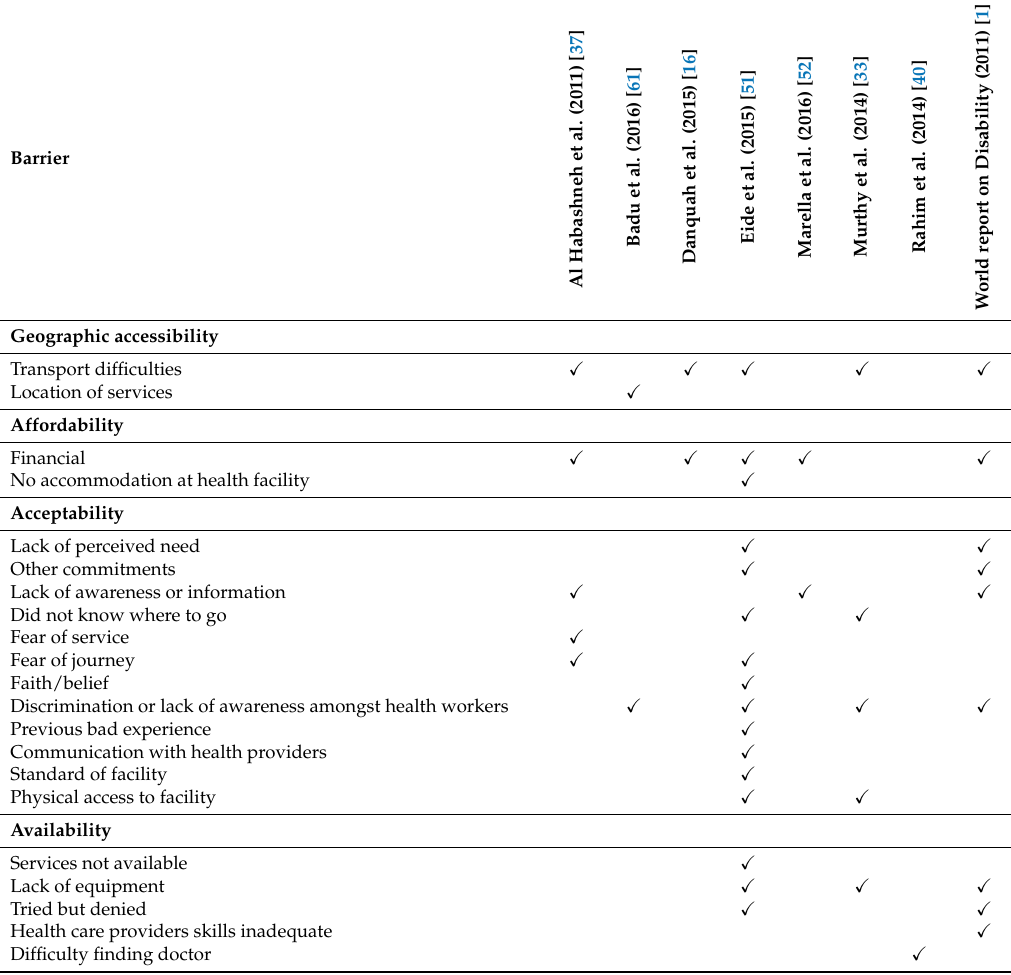
Table 8. Barriers to accessing health services reported in included